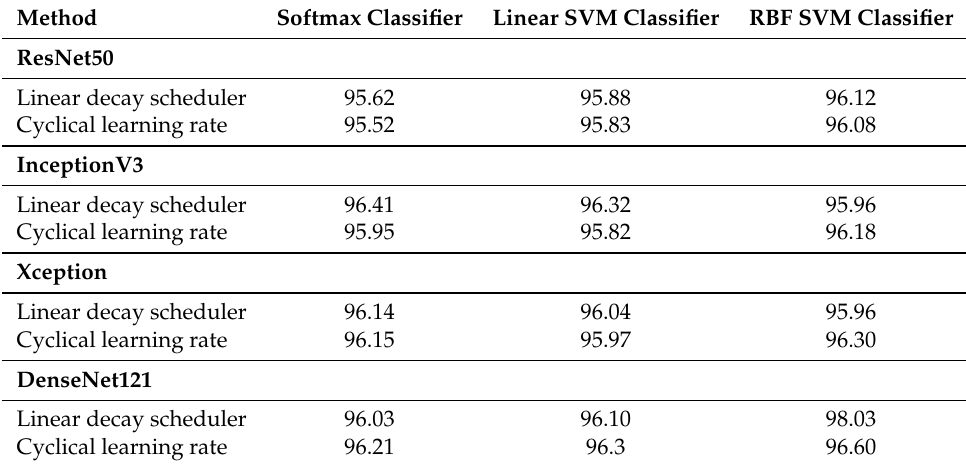
Table 1. Overall accuracy (%) of the proposed method with a 50%/50% train/test ratio of the AID dataset. The bold text highlights the best accuracy per classifier.